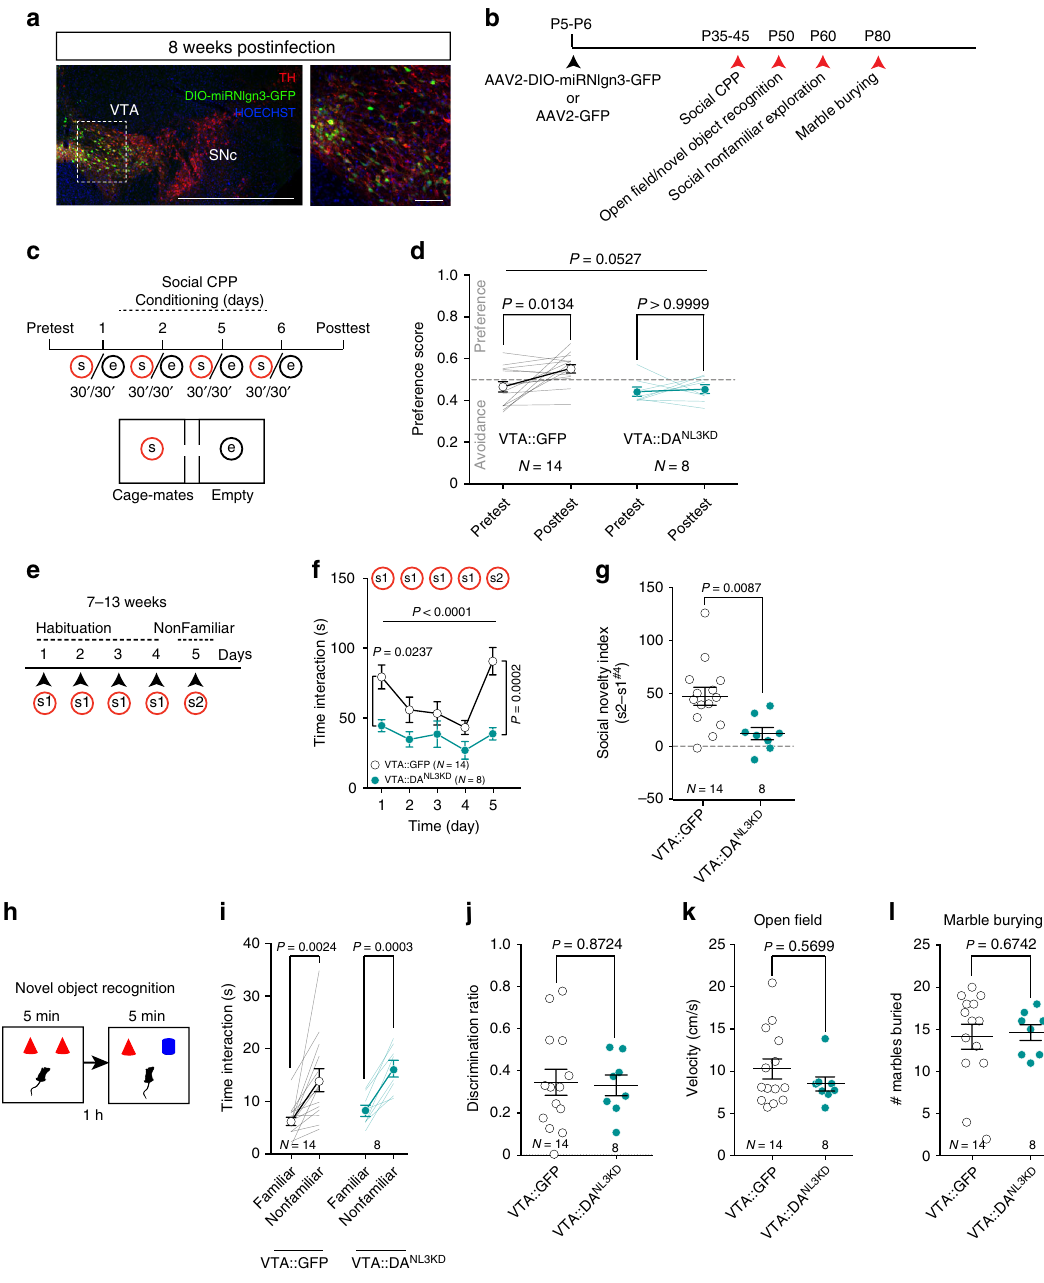
Fig. 5 Nlgn3 in VTA DA neurons is required for social exploration and the reinforcing properties of conspeci fi c interaction. a Left: representative image of coronal slice of VTA and SNc from an AAV2 DIO-miR Nlgn3 -GFP infected DAT-Cre mouse. Right: higher magni fi cation of VTA. Scale bar: 1 mm and 100 μ m. b Experimental schematic of behavioral test order in VTA-injected mice. c Experimental schematic of the social-CPP test. d Scatter plot of preference score measured during the Pre- and Post-TEST for VTA::GFP (mean and s.e.m for pre-TEST = 0.4642 ± 0.0247. Mean and s.e.m post-TEST = 0.5526 ± 0.0200), and VTA::DA NL3KD mice (mean and s.e.m for Pre-TEST: 0.4434 ± 0.0218; mean and s.e.m for Post-TEST: 0.4548± 0.0214). RM two-way ANOVA (time main effect: F (1, 20) = 4.24, P = 0.0527; virus main effect: F (1,20) = 6.103, P = 0.0226; time × virus interaction: F (1,20) = 2.527, P = 0.1276) followed by Bonferroni post hoc test for planned comparisons. e Experimental schematic of the habituation/nonfamiliar exploration task. f Mean social interaction plotted for VTA::GFP and VTA::DA NL3KD mice. RM two-way ANOVA (time main effect: F (4, 80) = 8.058, P < 0.0001, virus main effect: F (1, 20) = 9.164, P = 0.0067; time × virus interaction: F (4, 80) = 3.179, P = 0.0178) followed by Bonferroni ’ s post hoc test. g Social novelty index for VTA::GFP and VTA:: DA NL3KD mice. Unpaired t test ( t (20) = 2.908). h Experimental schematic of novel object recognition test. i Time spent investigating a novel and a familiar object. Paired t test (VTA::GFP: t (13) = 3.763. Mean and s.e.m familiar = 6.199 ± 0.805, mean and s.e.m novel = 14.03 ± 2.188. VTA::DA NL3KD : t (7) = 6.518. Mean familiar = 8.226, s.e.m ± 1.069, mean novel = 16.2, s.e.m ± 1.582). j Discrimination ratio for object discrimination plotted for VTA::GFP and VTA:: DA NL3KD . Unpaired t test ( t (20) = 0.1627). k Mean velocity of VTA::GFP and VTA::DA NL3KD mice during a 7 min open fi eld test. Mann – Whitney U = 47. l Number of marbles buried plotted for VTA::GFP and VTA::DA NL3KD . Mann – Whitney U = 49.5. N numbers indicate mice. All error bars are